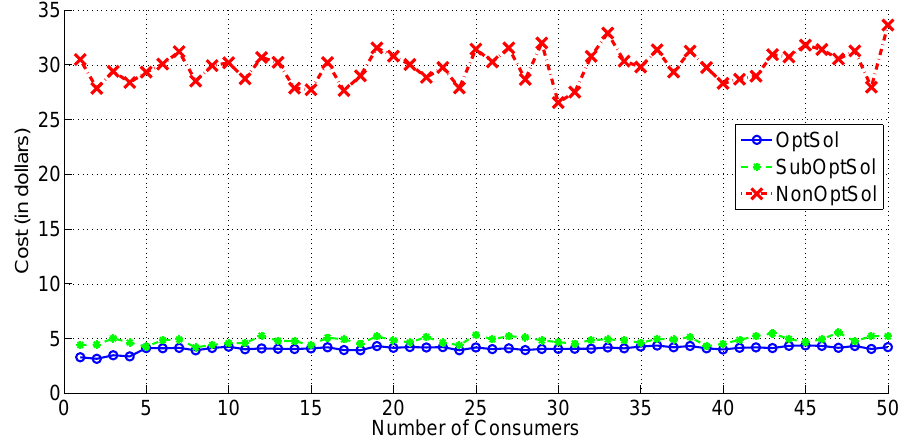
Figure 6. Fair Cost Minimization For 50 Consumers.